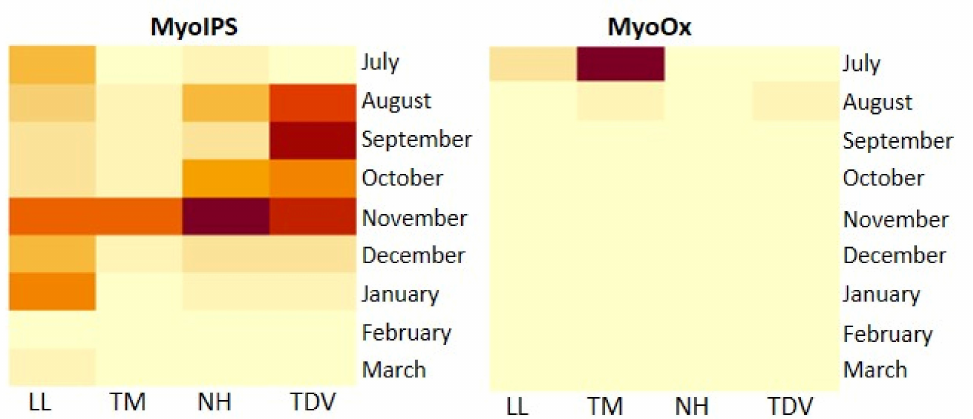
Figure 7. Heatmap of MyoIPS and MyoOx gene expression in the juice of Lanelate (LL), Tarocco Meli (TM), Newhall (NH), and Tarocco TDV (TDV) genotypes from July to March. Gene expression decreases according to the colour scale, from rust red to creamy yellow.